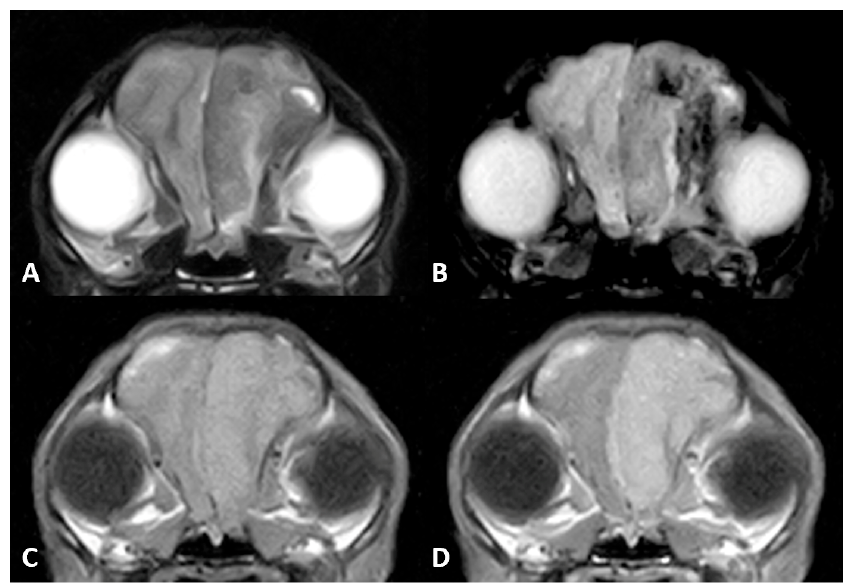
Figure 2. MR imaging of the brain of Case 2. ( A ) Transverse images at the level of the frontal lobes on T2w, ( B ) gradient echo sequences (T2*), ( C ) T1w and ( D ) T1w postcontrast (T1w+c). An extra-axial mass is seen in the left frontal cortex, hypointense on T2w images. There were gradient echo signal voids adjacent to the mass, compatible with intraparenchymal bleeds. Note the marked enhancement after contrast administration.